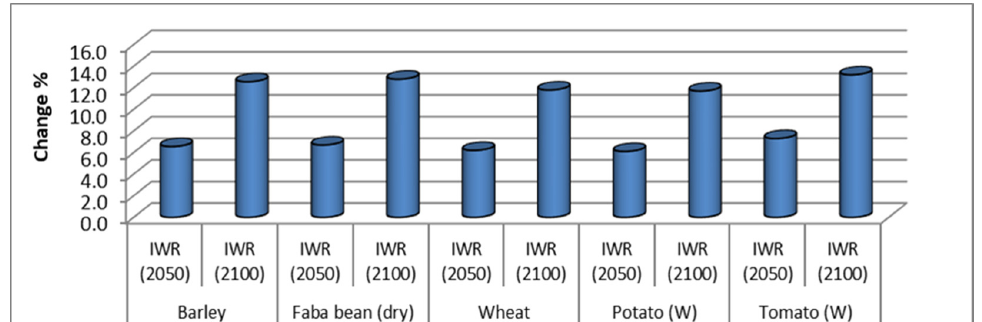
Figure 6. Change percentage in irrigation water requirements (IWR) for some main winter crops in Middle Egypt under climate change conditions compared to current conditions.